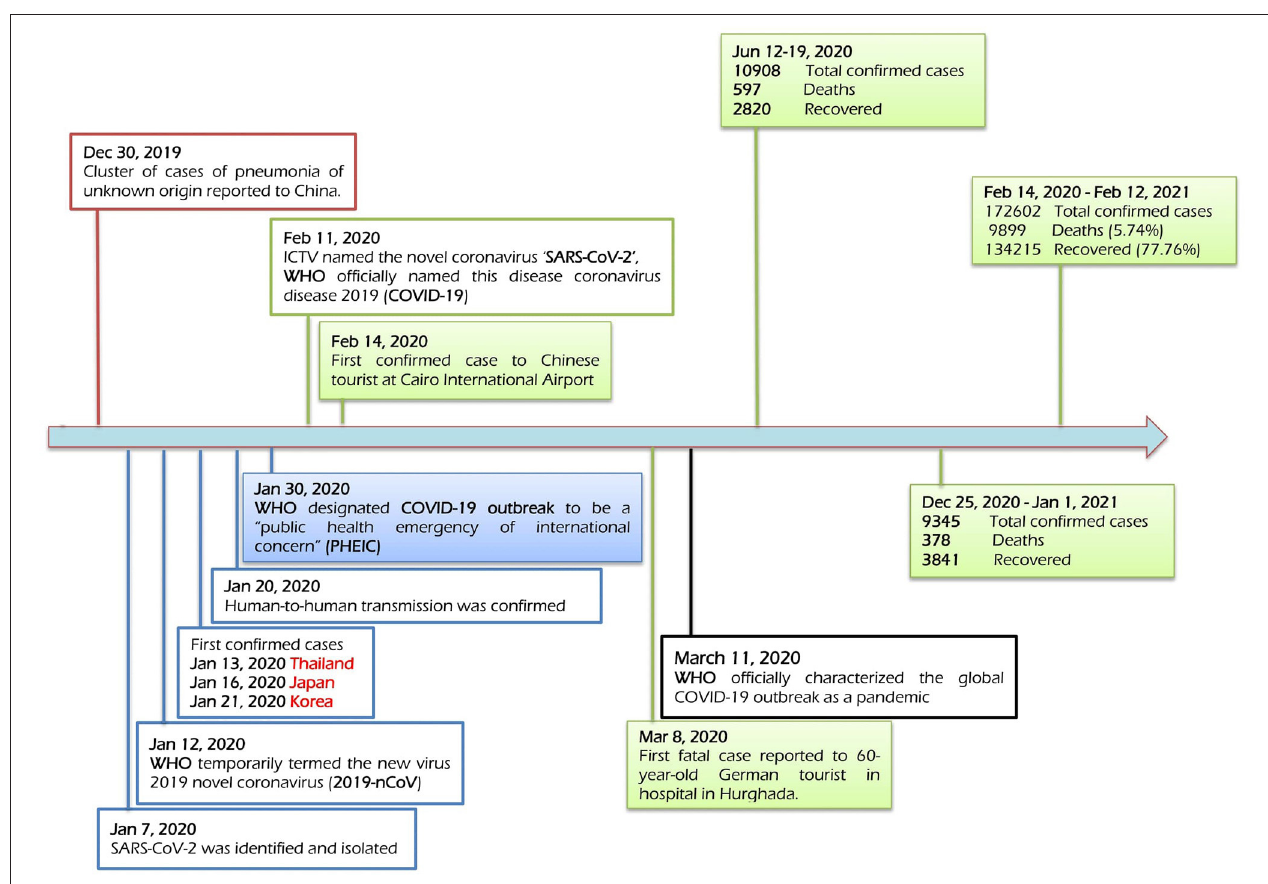
FIGURE 3 | Timeline of the key events of the COVID-19 outbreak in Egypt. This timeline has recorded the events chronologically since the emergence of SARS-CoV-2 in China till the appearance of the first case in Egypt, forwarding till April 2021. It has recorded the first virus case (February 14, 2020) and the first death case (March 8, 2020). It has recorded the first and second waves of COVID-19 in Egypt in mid-June and late-December 2020, respectively.